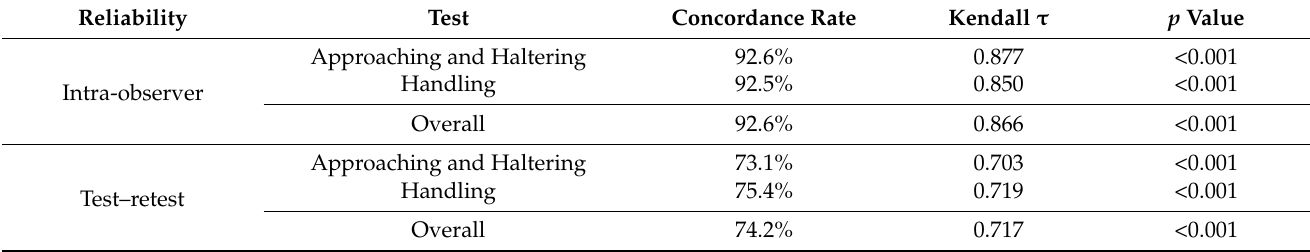
Table 4. Indices of intra-observer and test–retest reliability for the Approaching and Haltering and Handling Tests.